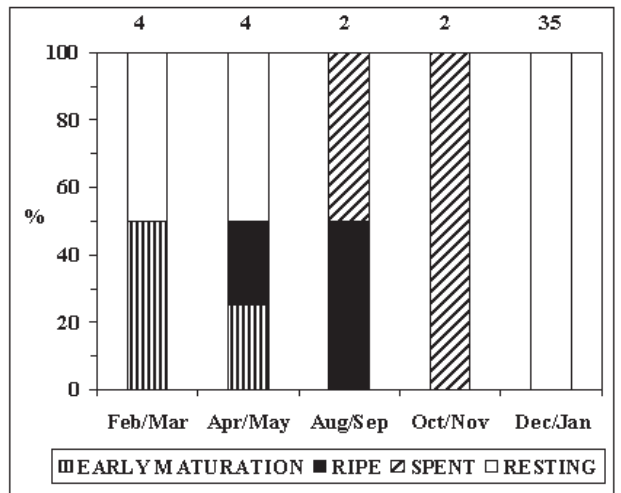
Fig. 15 . Relative frequency of the stages of maturity of the females of Mycteroperca bonaci .